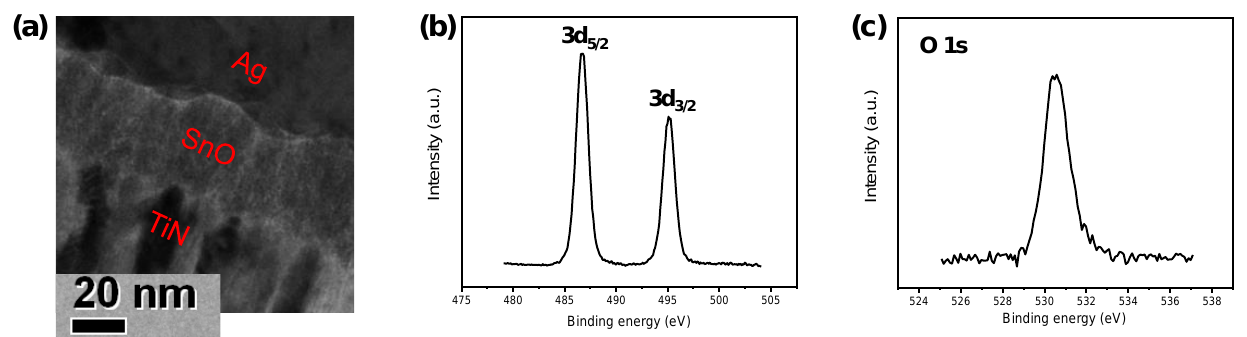
Figure 1. ( a ) TEM image of Ag/SnO x /TiN stack. XPS spectra of ( b ) Sn 3d and ( c ) O 1s.